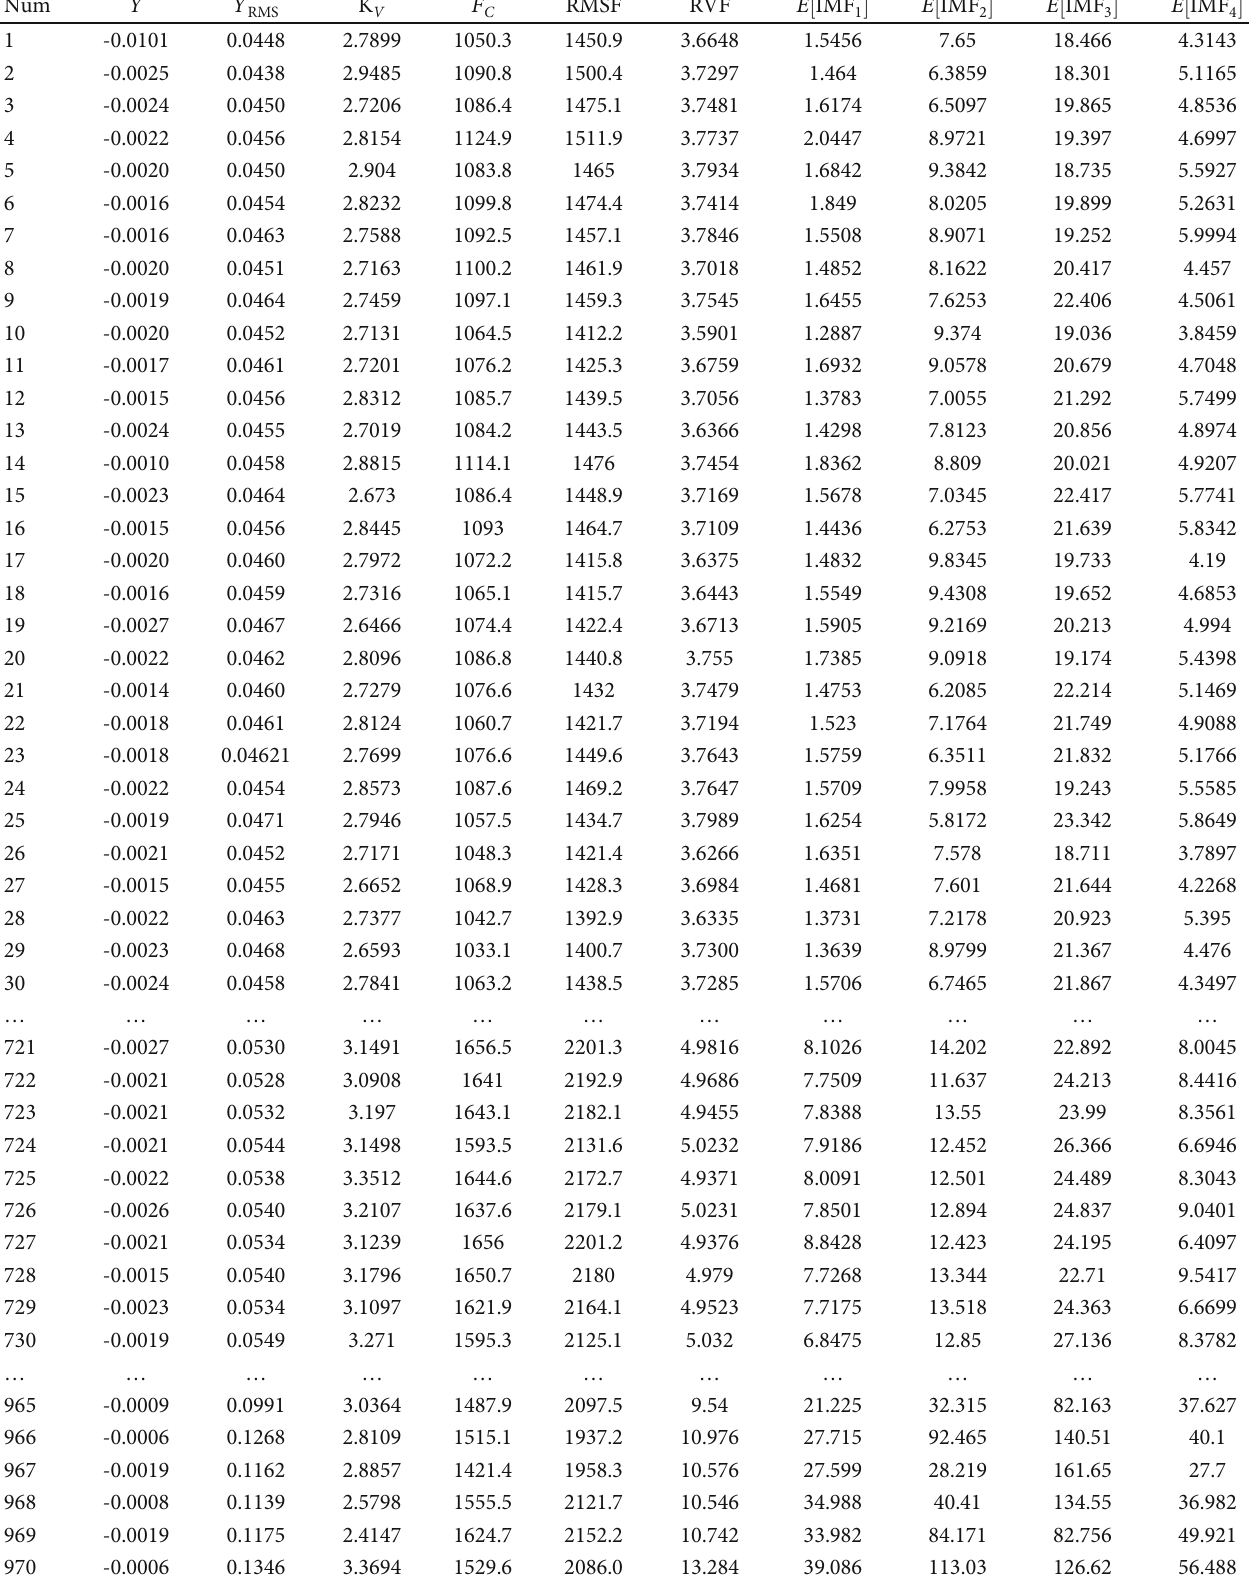
Table 2: Original feature parameter matrix for fl exible material R2R system roller vibration